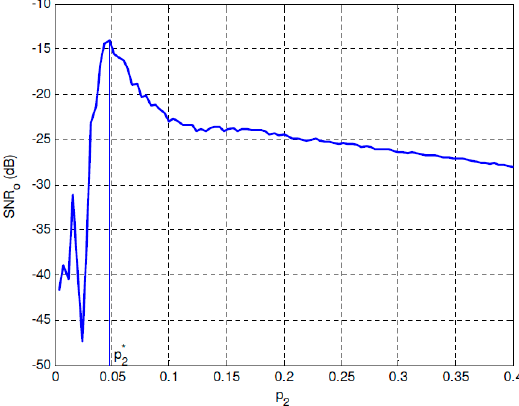
Figure 4. SNR o performance of the overdamped bistable SR system with a = 2 and b = 1 under SNR i = − 25 dB.